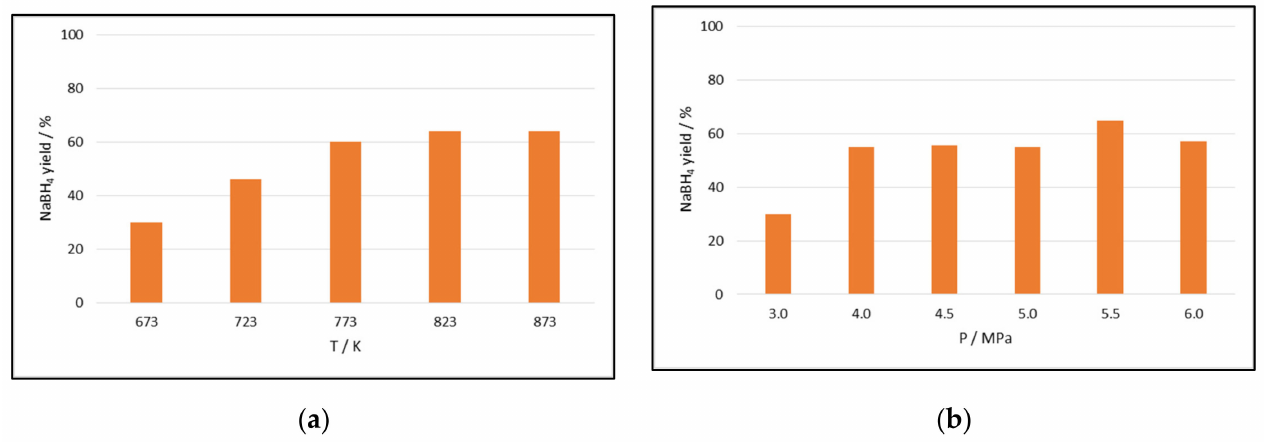
Figure 6. Values of NaBH 4 yield vs. ( a ) Temperature T and ( b ) Pressure P for t = 1 h. Adapted from